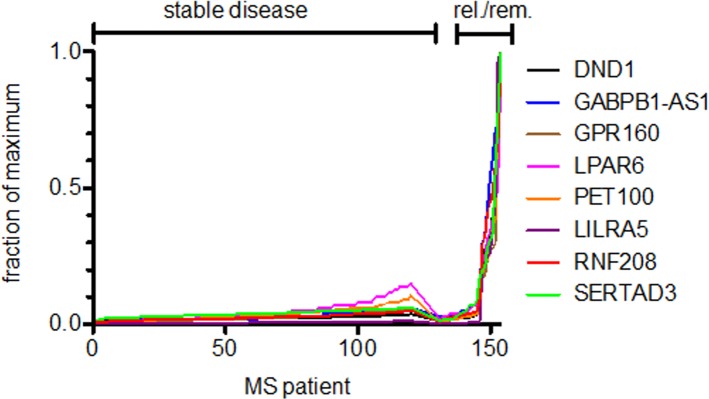
Expression levels of the indicated genes in subjects with MS with stable disease activity compared to those undergoing relapse and remission.Expression levels of the indicated genes were determined by PCR and normalized to GAPDH. Results are expressed as the fraction of the maximum level of expression of each gene. Subjects are grouped into those with stable disease (N = 125) and those undergoing relapse/remission (N = 24).